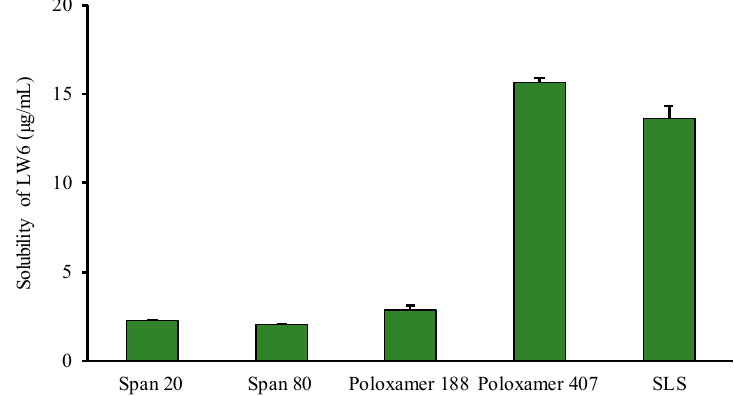
Figure 4. Effect of surfactants on the solubility of LW6. Data are expressed as the mean ± standard deviation (n = 3).